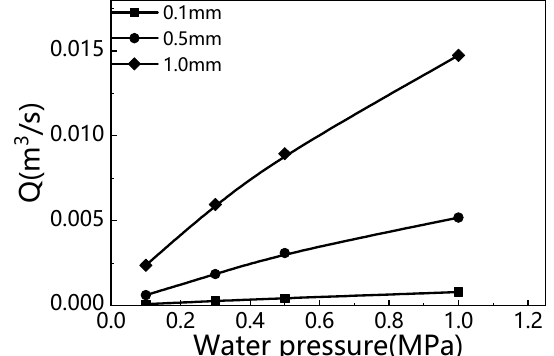
Figure 19. Two-dimensional model of fractured rock mass.